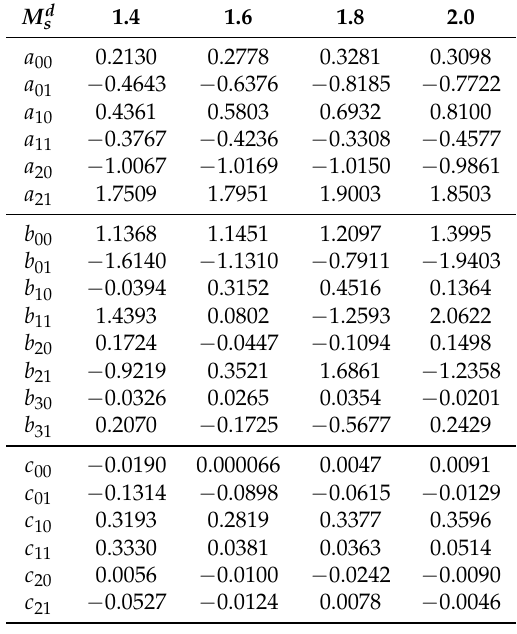
Table 1. Coefficient parameters in Equations (26)–(35) in servo